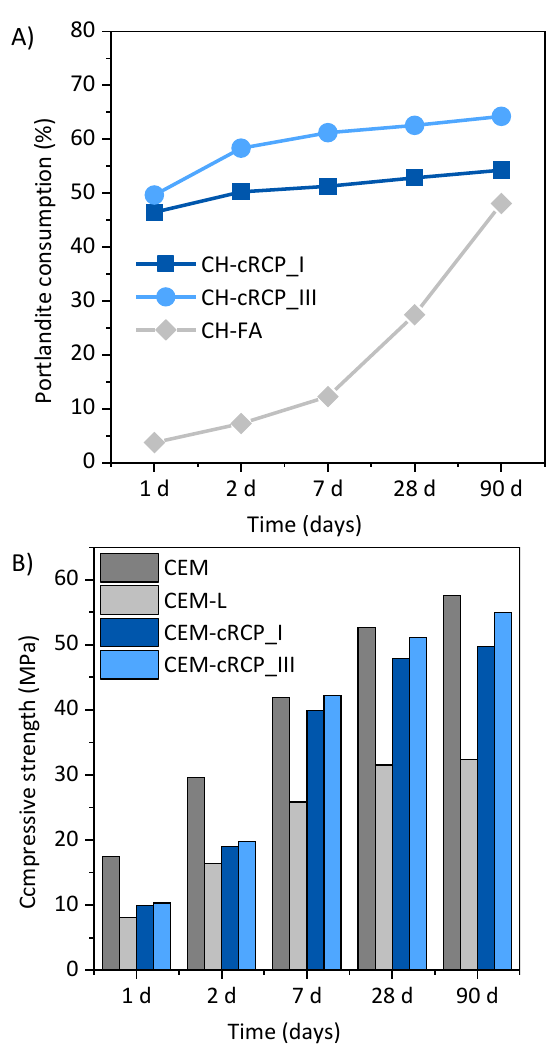
Figure 5. (A) Consumption of portlandite in the synthesized cements. (B) Evolution of the compressive strength in composite cements (see text for further explanation). cRCP_I – carbonated cement paste based on CEM-I Portland cement (acc. to EN 197-1), cRCP_III